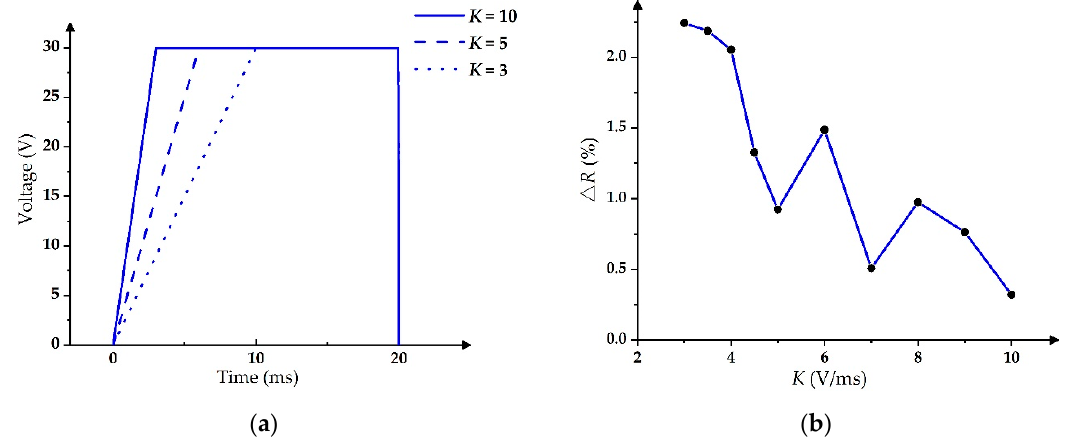
Figure 9. Slope-driving waveform and its aperture ratio performance [17,31]. ( a ) Slope-driving waveform with different K values. ( b ) Relationship between K and ∆ R .